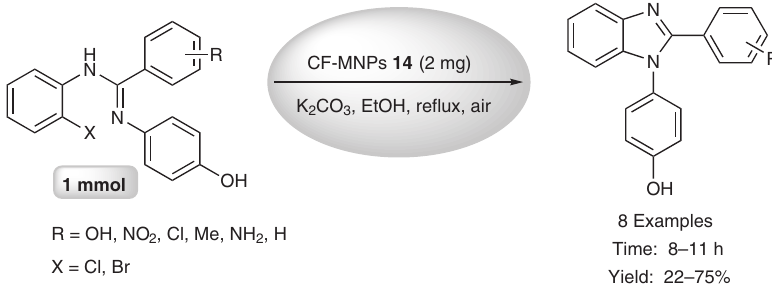
Scheme 15: CF-MNPs 14 catalyzed synthesis of benzimidazoles.